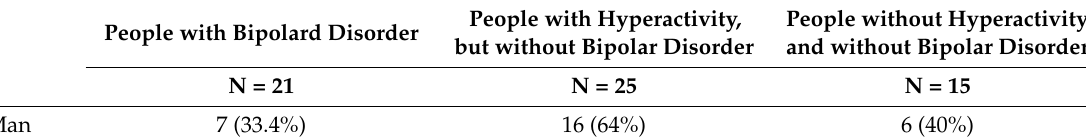
Table 1. Characteristics of the sample evaluated by gender in the three groups of people: (a) with bipolar disorder, (b) with hyperactivity without bipolar disorder, and (c) without hyperactivity and without bipolar disorder.